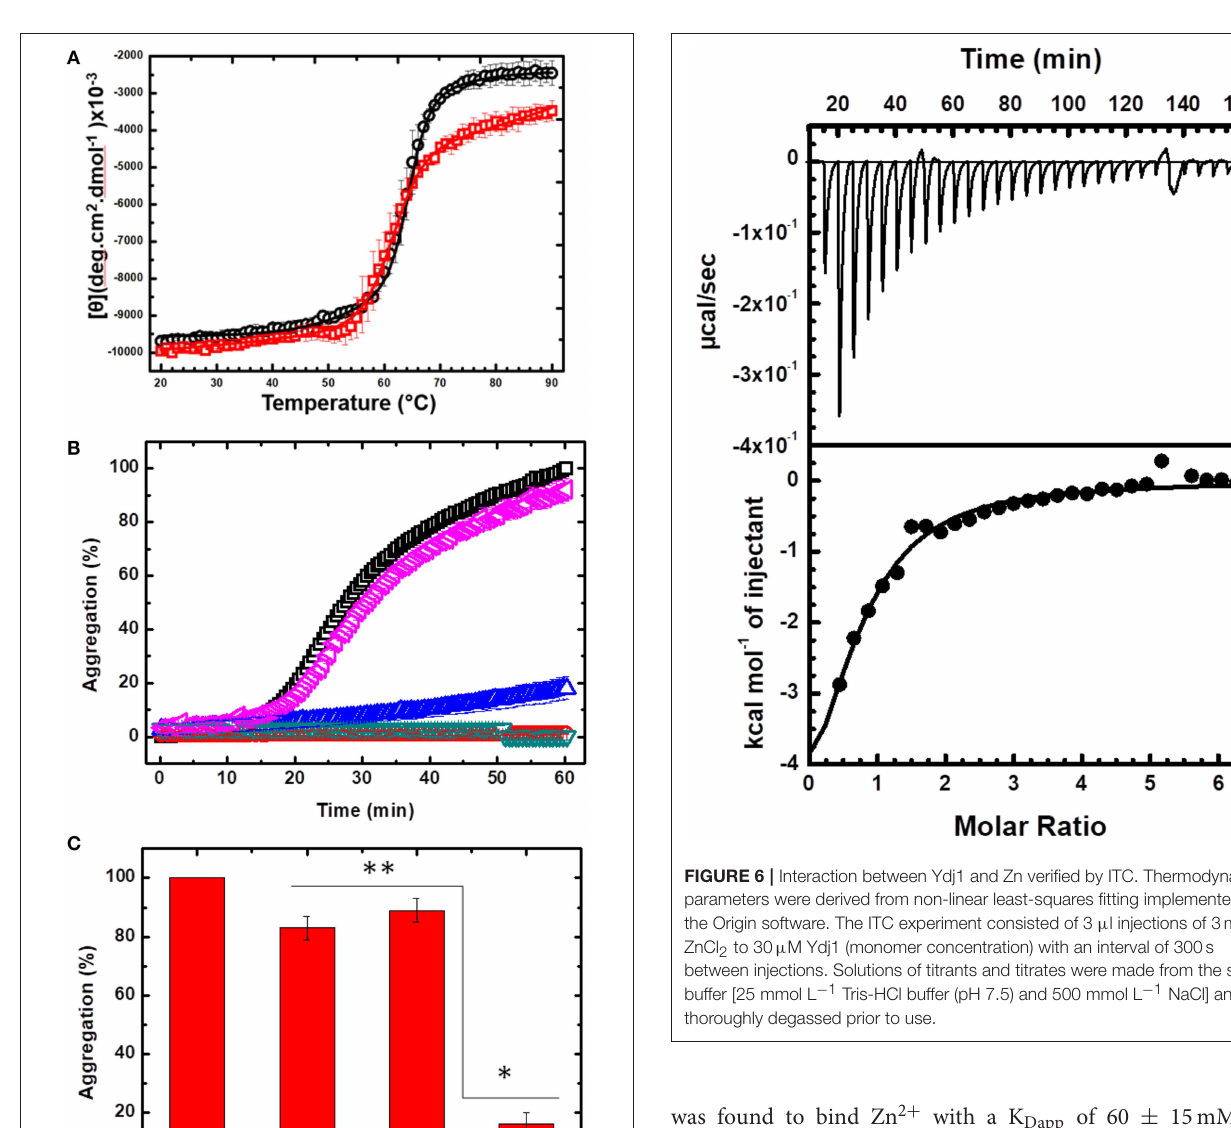
was found to bind Zn 2 + with a K Dapp of 60 ± 15 mM and a stoichiometry of 0.7 ± 0.1 Zn 2 + per monomer